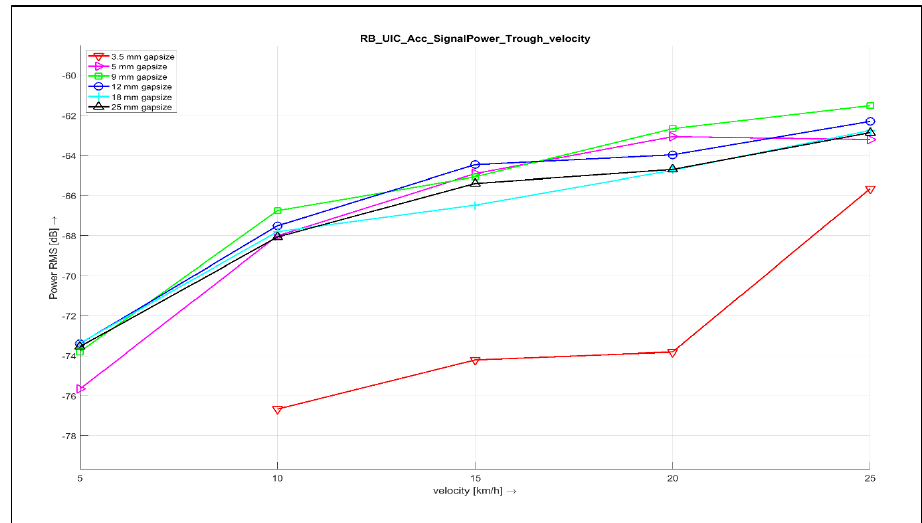
Figure 5 . Vibrational power reaching the trough as a function of train velocity and gap width . The lower red line in Figure 5 represents the tests where the gap width was 3.5 mm. These results differ from the other lines (tests) because for the 3.5 mm gap the rail joint was supported by a fishplate, in all other tests the fishplate was absent.